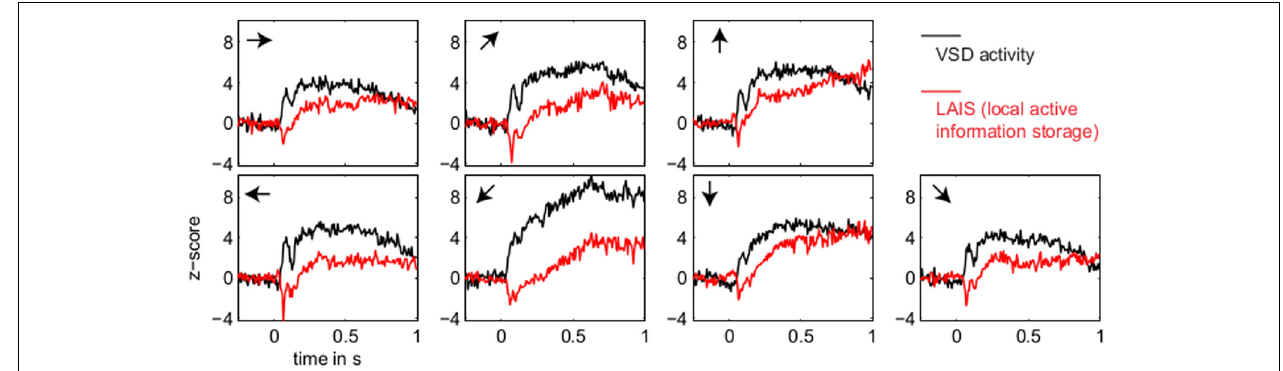
FIGURE 3 | Temporal evolution of VSD activity and local active information storage. Spatial averages over the 67 × 137 data pixels for VSD activity (black traces), and the LAIS (red traces) versus time. Motion directions are indicated by arrows for each panel. Note that LAIS for the vertical, the right, and the downward-right